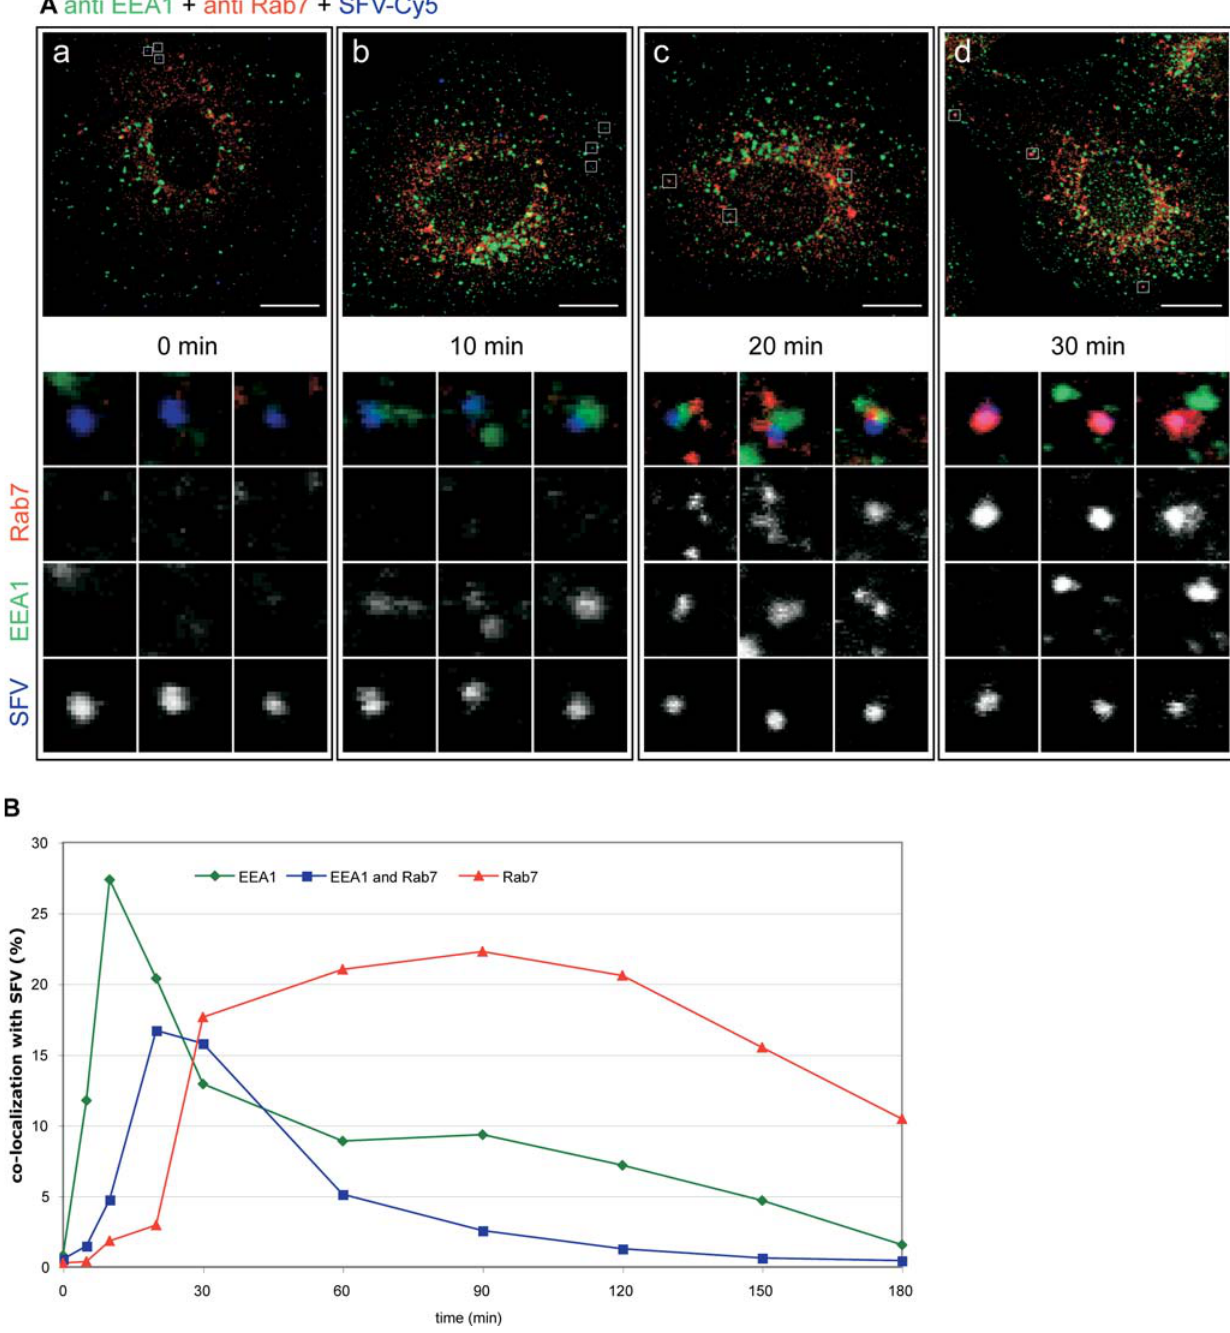
Figure 4. Progression of SFV through Endosomes Labeled for EEA1 and Rab7 (A) Confocal microscopy of Vero cells. SFV-Cy5 was allowed to bind to Vero cells (at a MOI of 20) for 60 min at 4 8 C, followed by transfer to 37 8 C and fixed after different times (a, 0 min; b, 10 min; c, 20 min; d, 30 min) and immunolabeled with EEA1 and anti-Rab7 antibodies. Shown are three viruses for each time point. Scale bars represent 10 l m. In panel a, SFV do not co-localize with any endosomal marker; in panel b, SFV are localized in EEA1-positive endosomes; in panel c, SFV are localized in EEA1- and Rab7-positive endosomes; and in panel d, SFV are localized in Rab7-positive endosomes. (B) Quantification of SFV-Cy5 in endosomes that contain EEA1 but no Rab7 (green line), endosomes that contain both (blue line), and structures that contain only Rab7 (red line) over time. The values are normalized such that 100% represents the number of cell-associated viruses at each time point corrected for the degradation. DOI: 10.1371/journal.pbio.0030233.g004 with either of the endosomal markers (red and green). After endosomes positive for both EEA1 and Rab7, and from 30 min onwards (Figure 4A, panel d), an increasing fraction was 10 min (Figure 4A, panel b), most of the virus particles co- seen in organelles stained by Rab7 alone. localized with EEA1 in early endosomes. After 20 min (Figure 4A, panel c), many of the virus particles were located in the To quantify these observations, we viewed 260 virus PLoS Biology |